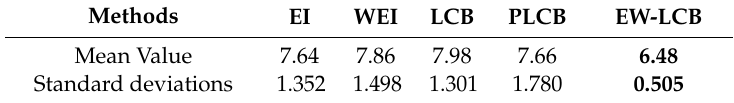
Table 2. Comparison results of di ff erent approaches of the illustrated